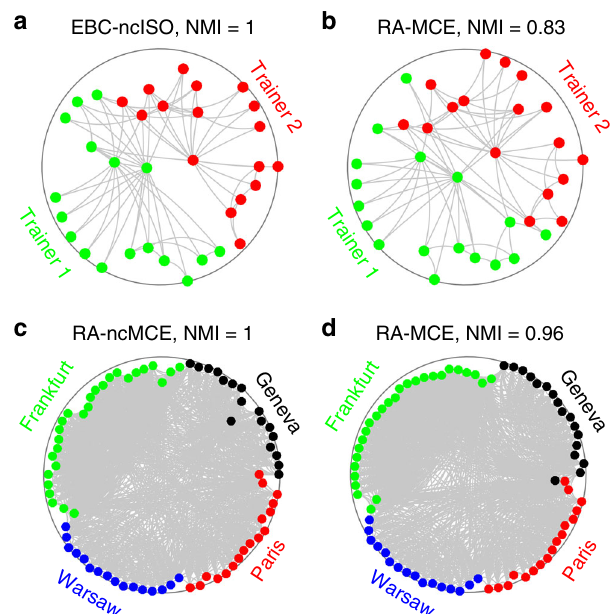
Fig. 7 Communities in Karate and Opsahl_11 networks. a , b Karate network embedded with EBC-ncISO-EA and RA-MCE-EA. The network represents the friendship between the members of a university karate club in the United States. The two real communities are highlighted, they are formed by a split of the club into two parts, each following one trainer. The NMI obtained by the Louvain community detection algorithm is reported, where the embedding coordinates were used to weight the input matrix: observed links are weighted using the hyperbolic distances between the nodes and non-observed links using the hyperbolic shortest paths (see “ Methods ” section for details). NMI is the normalized mutual information and represents the shared information between two distributions, normalized between 0 and 1, where 1 indicates that the communities detected by the algorithm perfectly correspond to the ground truth communities (see “ Methods ” section for details). c , d Opsahl_11 network embedded with RA- ncMCE-EA and RA-MCE-EA. This is a type of intra-organizational network, where a link indicates that the connected employees have both awareness of each other ’ s knowledge and skills on the job. The four real communities are highlighted, they are related with the location of the employers. All the approaches here adopted are adjusted according to EA strategy, although this is not explicitly reported in the subtitles for brevity. Note that the angular coordinates of the embedding in b , d have been aligned for a better visualization, respectively, to the ones in a , c , as described for the scatter plots in Fig.